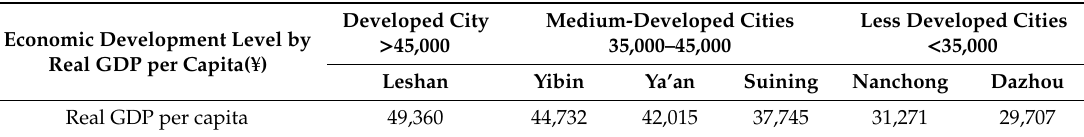
Figure 1. The study area. Table 1. The grouping of cities in the study area according to economic development level.